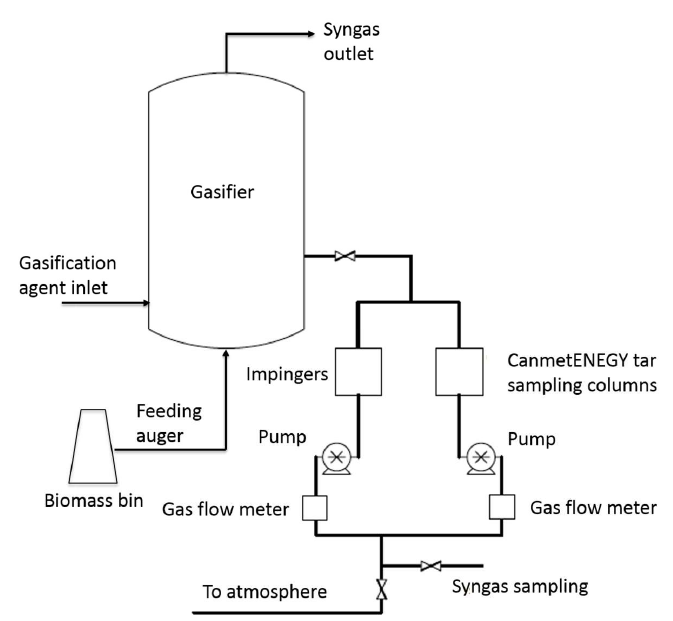
Figure 2. Side-by-side syngas and tar sampling arrangement using impingers and the CE-O (CanmetENERGY-Ottawa) device. The sampling port is located about 2/3 distance from the bottom the of the reactor.